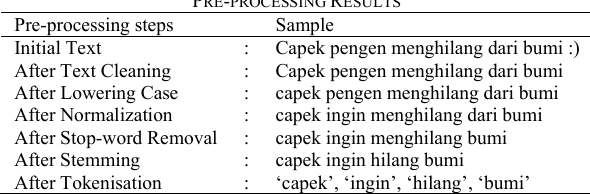
TABLE 3 P RE - PROCESSING R ESULTS